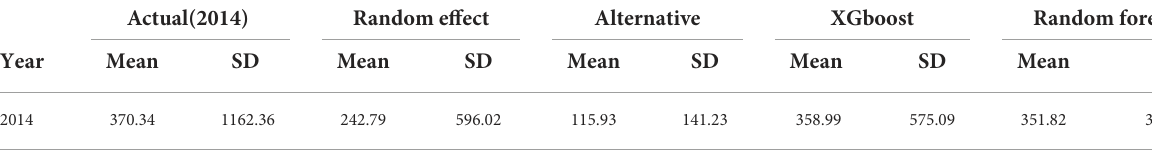
TABLE 7 Actual and predicted average total annual losses per policy as of the evaluation date.